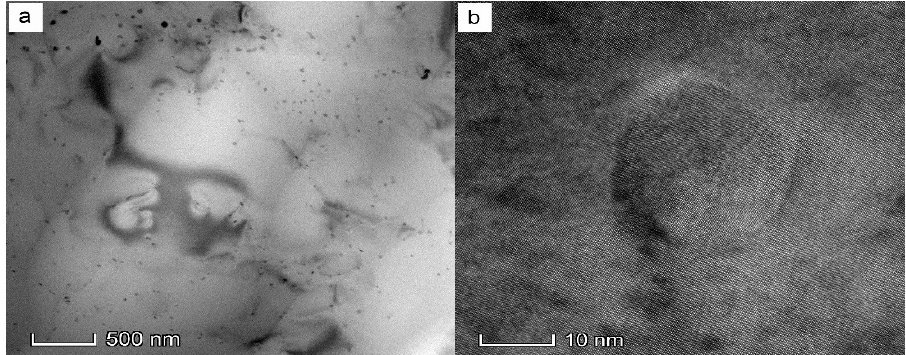
Figure 6. ( a ) TEM and ( b ) HRTEM images of the Al-Mg-0.3Sc alloy deposits after heat treatment.